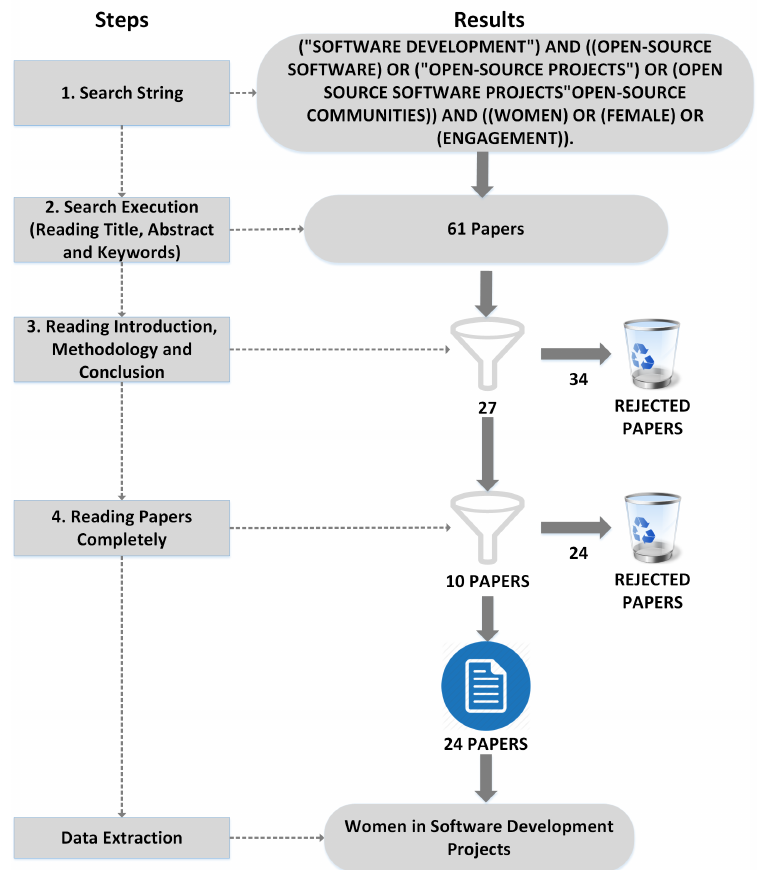
Figure 1. Steps of the selection of works strategy (Adapted from